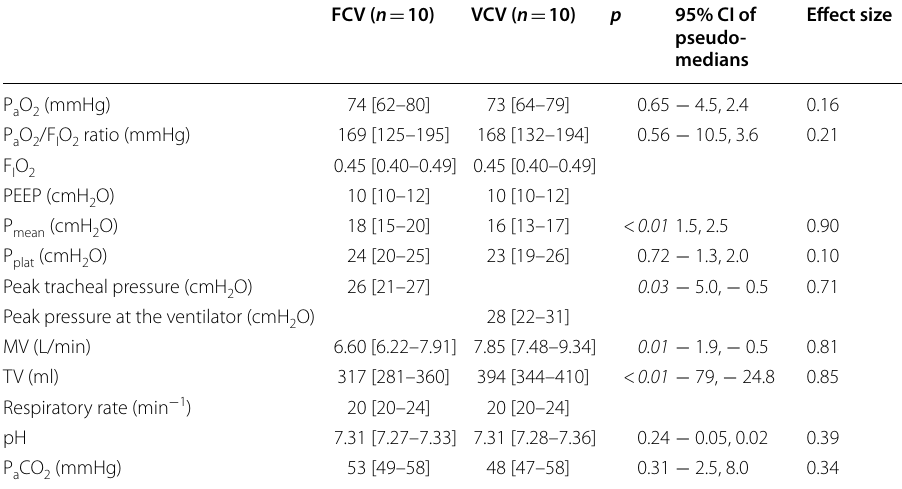
Table 2 Comparison of flow-controlled ventilation with volume-controlled ventilation